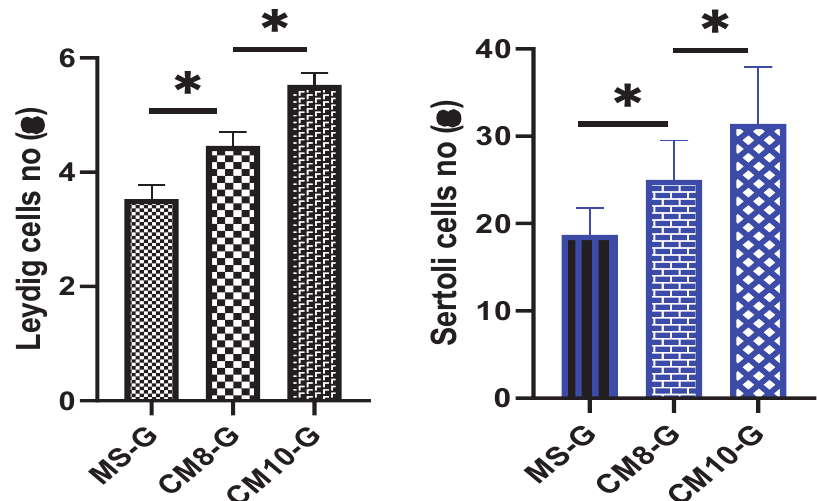
Figure 2. Post Hoc analysis on Leydig and Sertoli cells in three groups. *p <